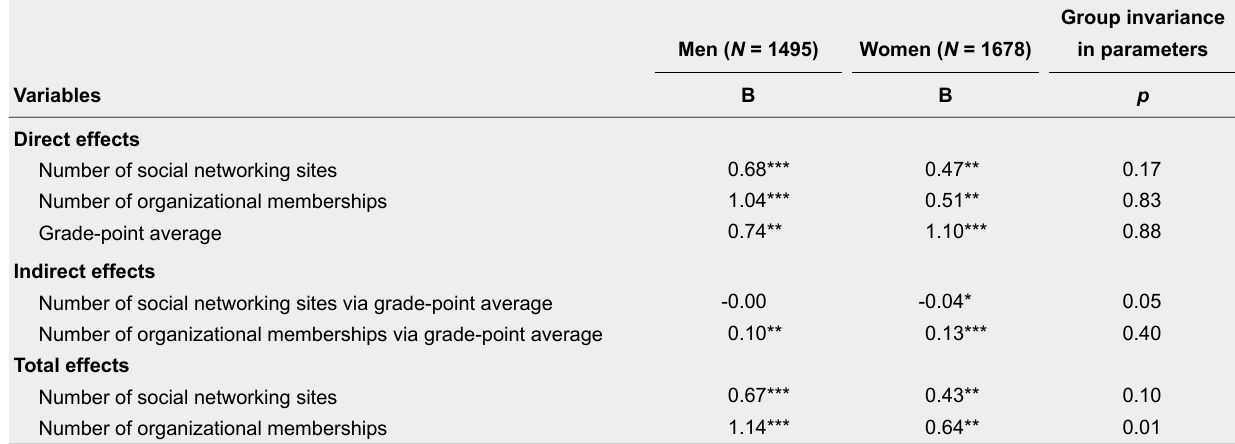
Gender Variations in the Effects of Number of Social Networking Sites, Number of Organizational Memberships, and Grade-Point Average on Global Social Responsibility Scale